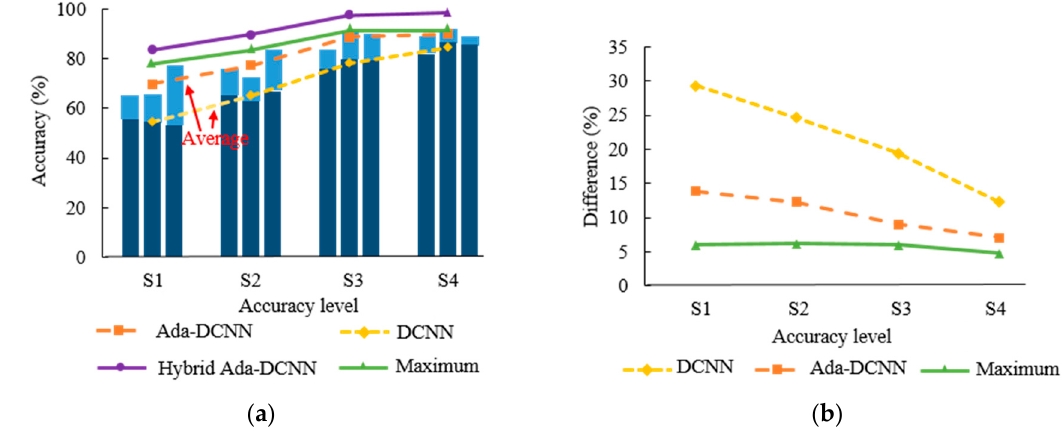
Figure 11. The comparison of the hybrid Ada-DCNN, Ada-DCNN, and DCNN in 4 accuracy levels: ( a ) The accuracy of hybrid Ada-DCNN, Ada-DCNN, and DCNN; ( b ) The comparison of the hybrid Ada-DCNN, Ada-DCNN, and DCNN in 4 accuracy levels.